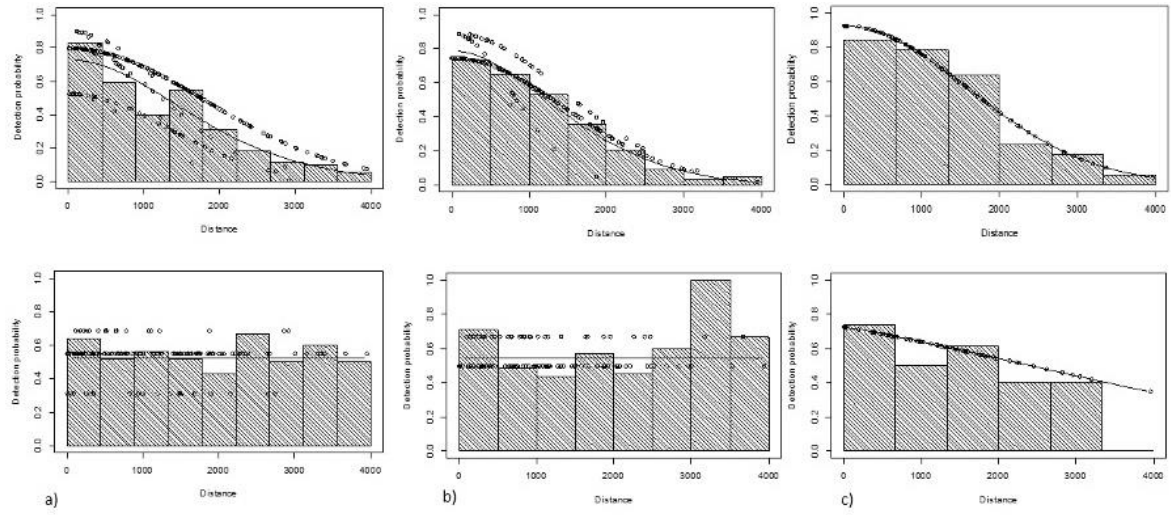
Figure 5. 2008 – 2013 survey detection function curves for pooled detections (top) and the conditional detection probabilities of platform 1 (bottom) for (a) fin whales, (b) humpback whales, and (c) sperm